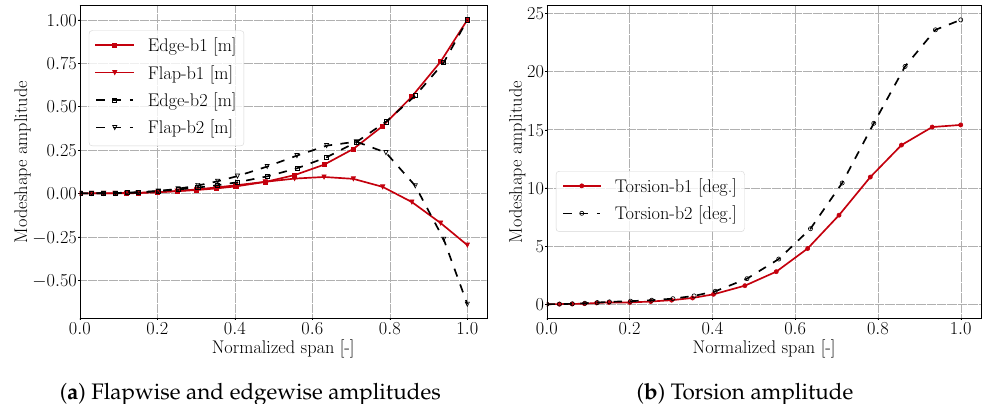
Figure 8. Second mode shape flapwise and edgewise shown in ( a ), and torsion amplitudes shown in ( b ) for both blade designs (Blade-1: b1, Blade-2: b2) (structural response only). Figure 9 shows the third mode shape amplitudes. Flapwise motions are dominant for both blades but the amplitudes of the motion over the blade span is different unlike the first two mode shapes shown in Figures 7 and 8. Other important dissimilarities between two blades are edgewise and torsion amplitudes. The Blade-2 edgewise amplitude almost reaches to 1 at the blade tip and its distribution is very similar to the second mode shape edgewise motion shown in Figure 8. So, there is a strong coupling between the second flapwise mode shape motion and the first edgewise mode shape motion. The torsion motion seems to be the result of both flapwise and edgewise motions in the mode shape and it is larger for Blade-2 than Blade-1.